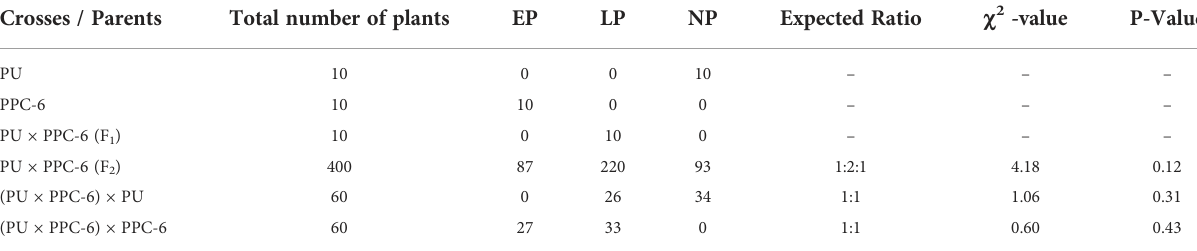
TABLE 1 Evaluation of the parents along with F 1 and F 2 and back-cross progenies for studying the inheritance of parthenocarpy. Crosses / Parents